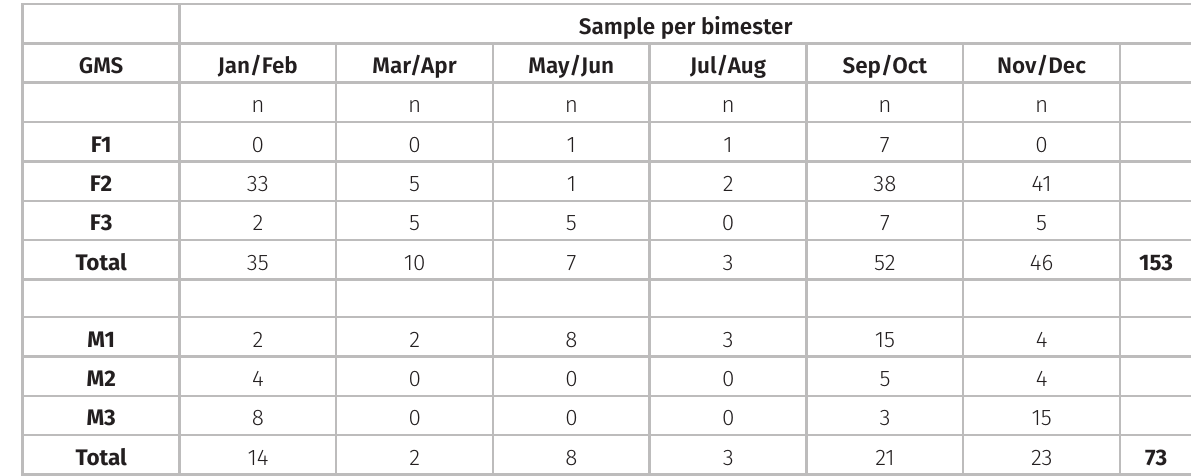
Table IV. The bi-monthly absolute distribution (n) of the gonadal maturation stages (GMS) of S. elegans females (F) and males (M) caught in the São Francisco River downstream of the Três Marias dam between January and December